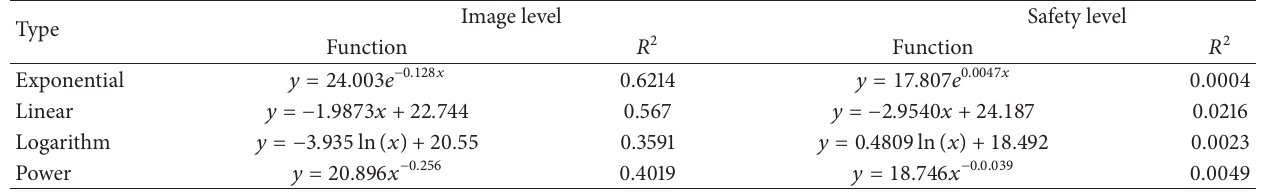
Table 5: Various regression lines of WTP and coefficient of determination ( 𝑅 2 ) according to function type for image level and safety